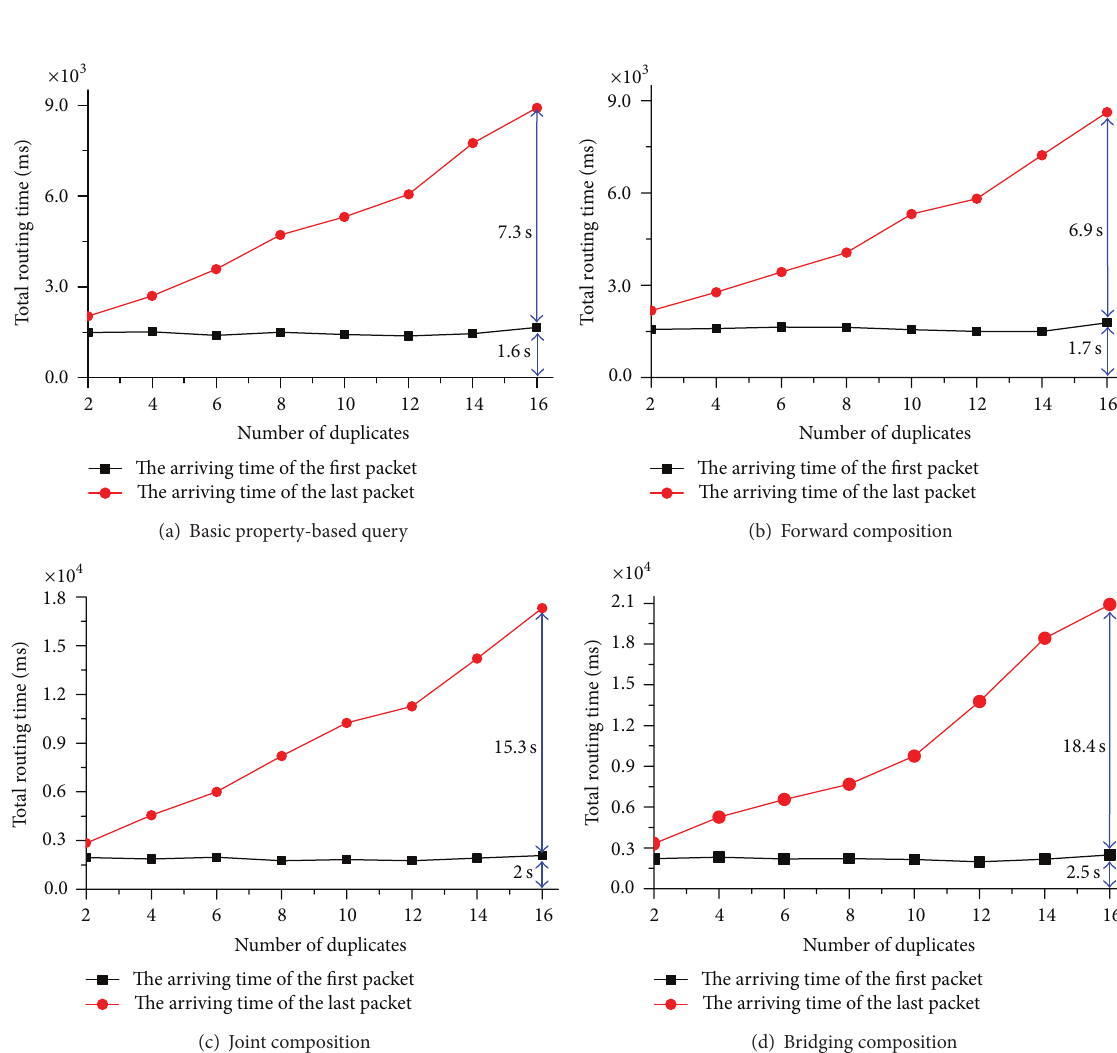
Figure 10: Testing results for total routing time with different duplicates (hops are